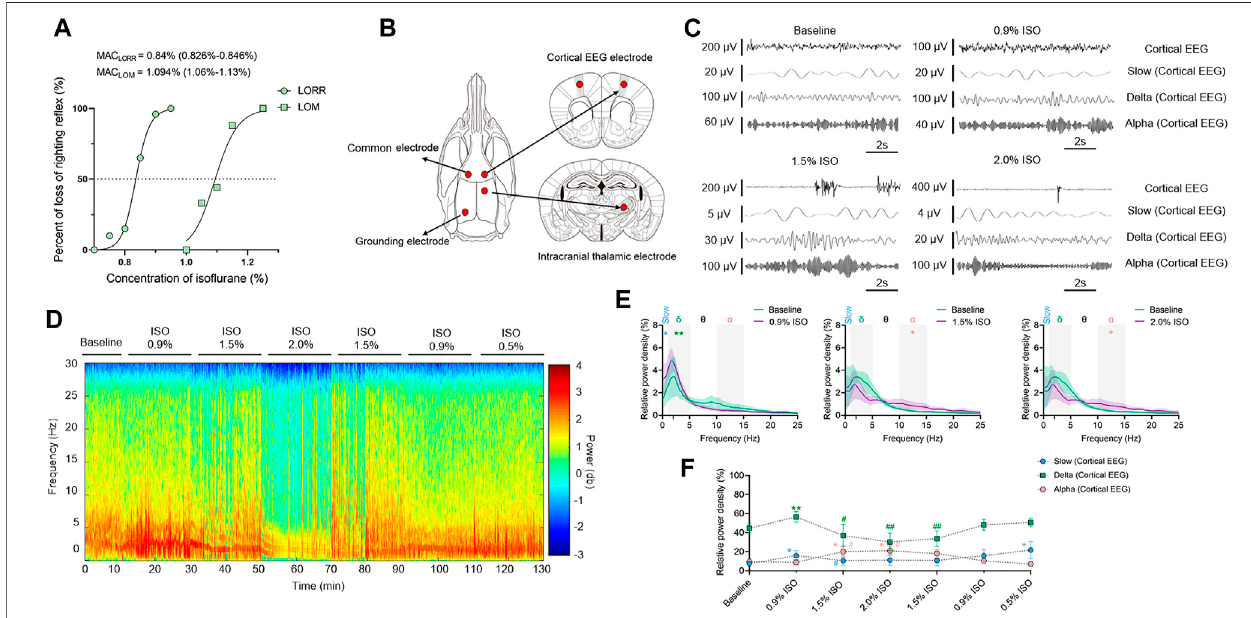
FIGURE 1 | EEG dynamics of the prefrontal cortex under iso fl urane anesthesia. (A) Concentration – response curves of iso fl urane-induced MAC LORR and MAC LOM ( n = 20/group), MAC LORR = 0.84% [0.83%, 0.85%] and MAC LOM = 1.09% [1.06%, 1.13%]. (B) Schematic of recording sites. Red dots represent locations where electrodes implanted. (C) Representative raw traces of cortical EEG in slow, delta, and alpha oscillations within the same period. (D) A representative spectrogram of corticalEEG. (E) Arelativepowerdensityof0.9%,1.5%,and2.0%iso fl uranecomparedwithbaseline.Shadingindicates95%CI. (F) Totalrelativepowerdensityof corticalEEGinslow,delta,andalphaoscillations.Comparisonsarebasedontherepeated-measures ANOVAforallexperimentsfollowedbyTukey ’ sposthoctest:* p < 0.05and** p < 0.01vs.baseline; # p < 0.05and ## p < 0.01vs.0.9%.Frequencyoscillations:slow(0.5 – 1 Hz),delta(1 – 5 Hz),andalpha(9 – 14 Hz).Valuesaremean[95% CI]. MAC, minimum alveolar concentration; CI, con fi dence interval; and ISO, iso fl urane.